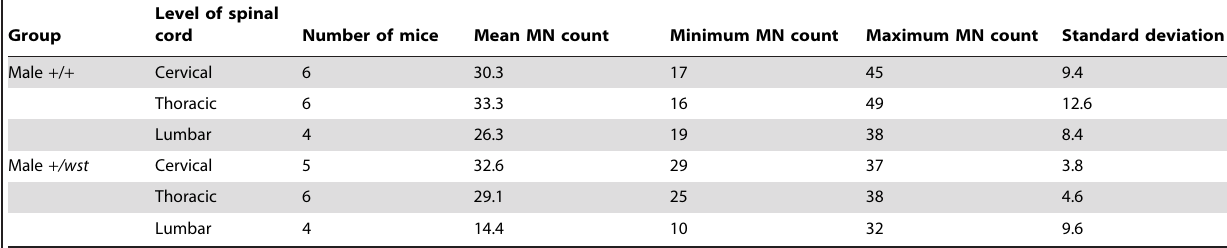
Table 1. Motor neuron numbers from the spinal cords of the ageing cohort.